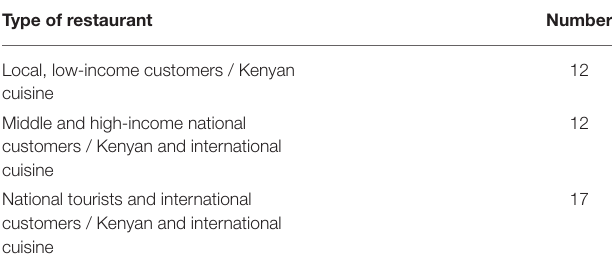
TABLE 2 | Classification of the sample according to the type of offer and the target clientele. Type of